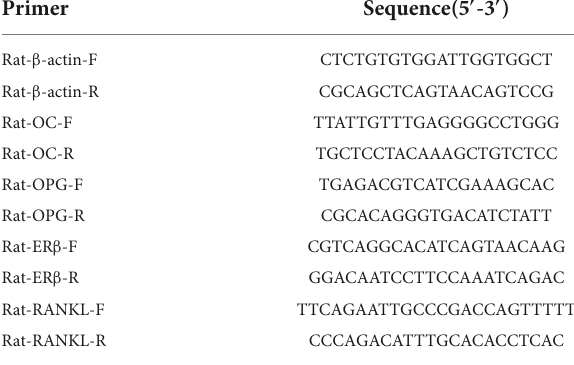
TABLE 2 Primer sequences of the genes involved in this study. Primer Sequence(5 (cid:48) -3 (cid:48)